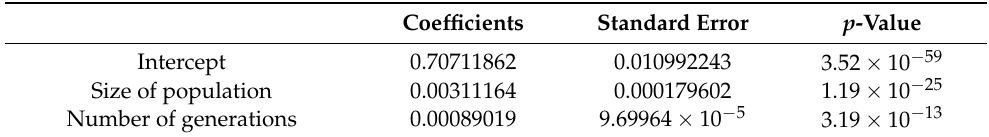
Table 6. Regression analysis